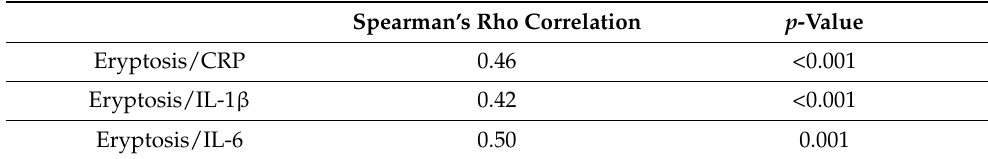
Table 3. Spearman’s rho correlations and p -values for eryptosis percentage and inflammatory marker levels.